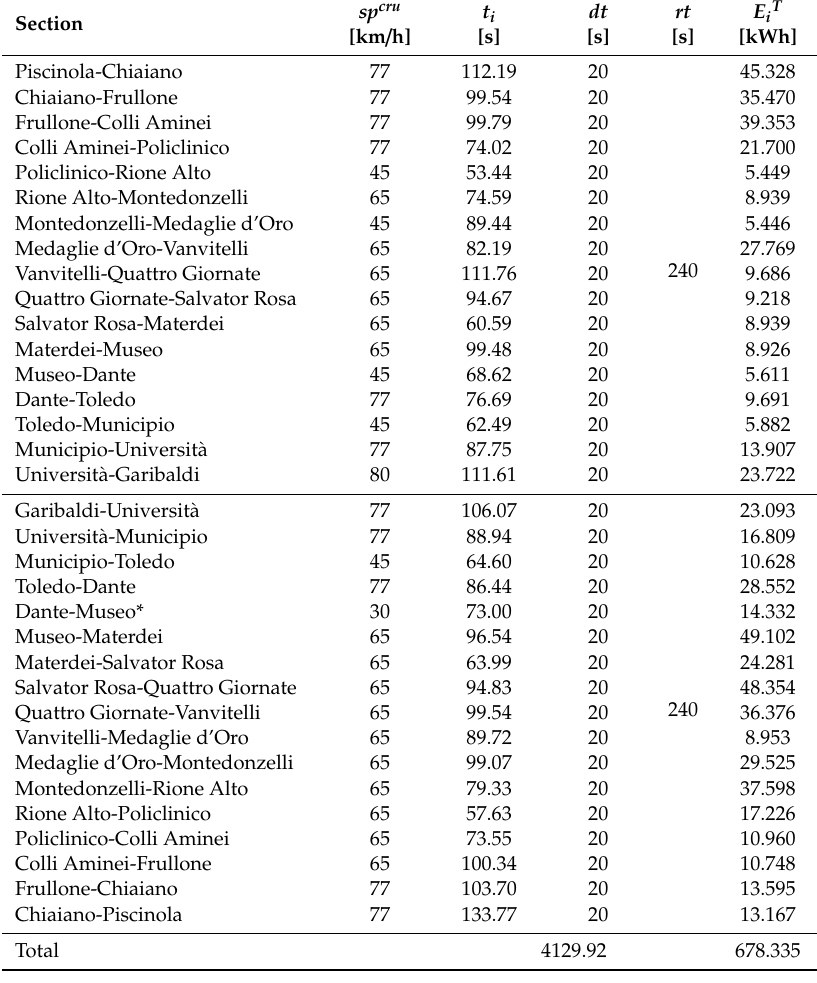
Table 3. Data before optimisation.